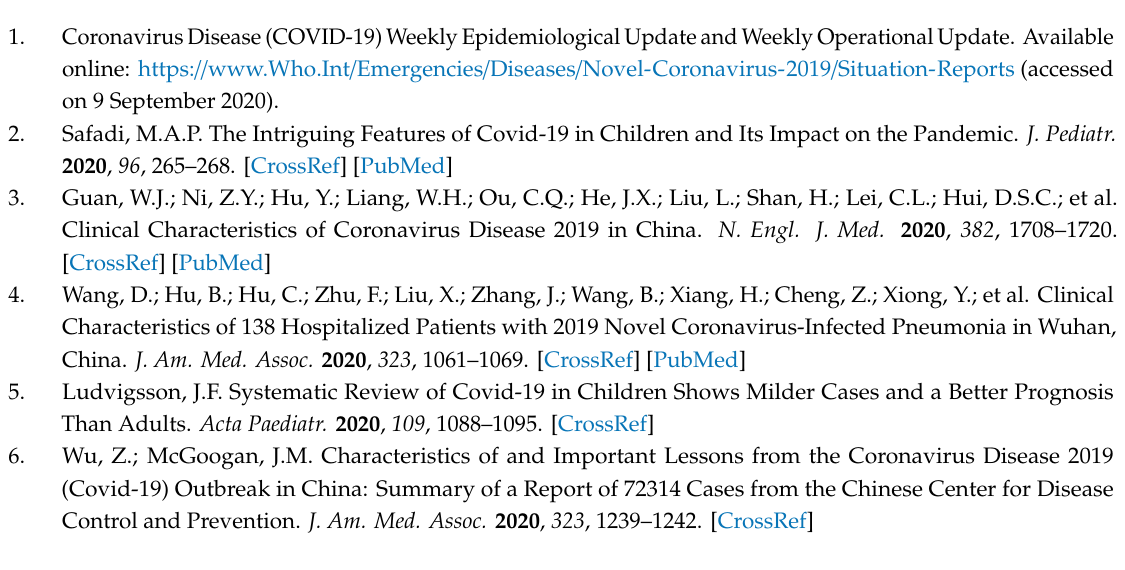
Figure S1: Age repartition of the included patients, Figure S2: Detailed clinical presentation of 4